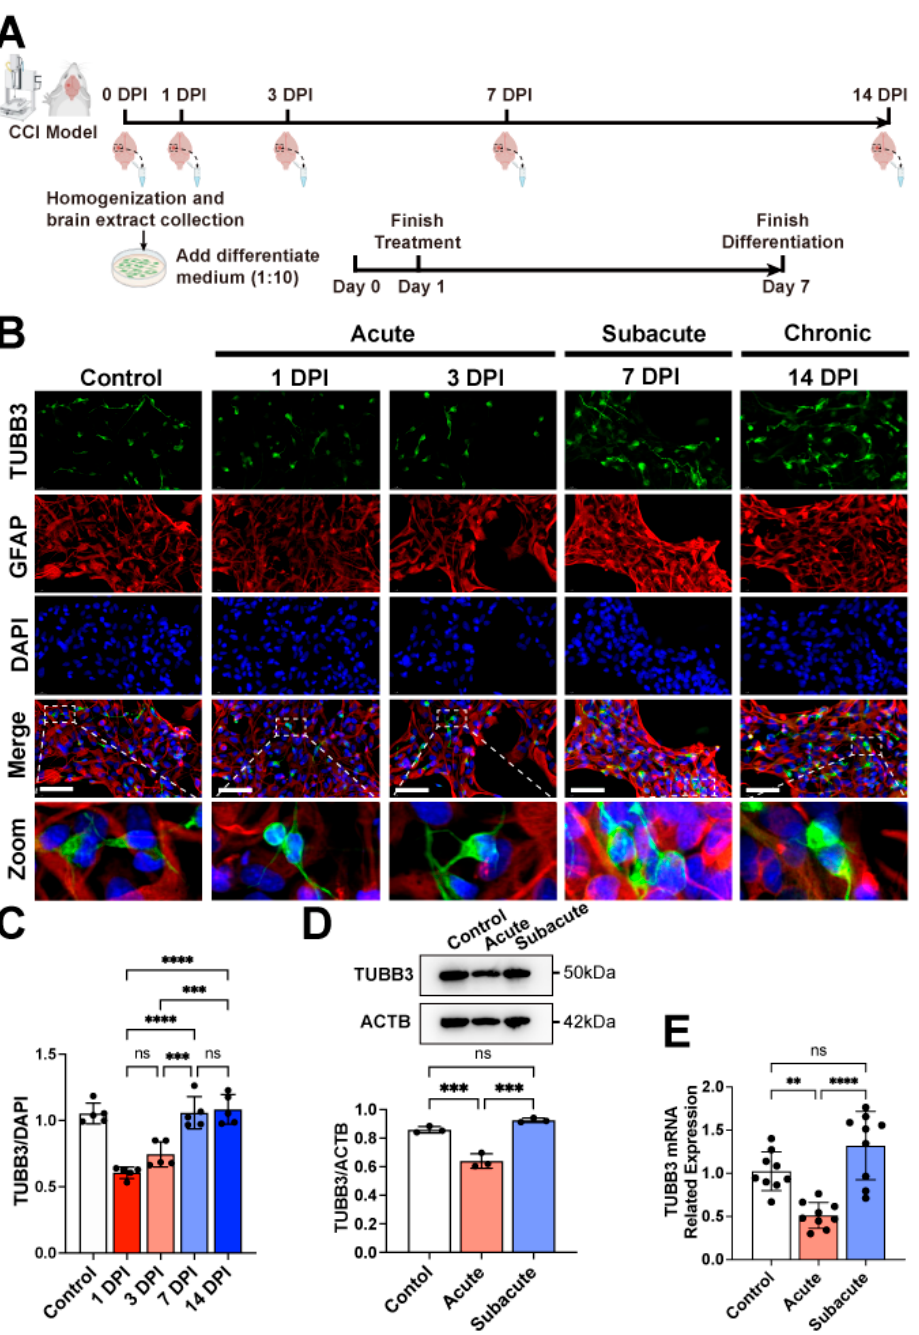
Figure 1. The neuronal differentiation of hNSCs within TBI brain extract at different phases. The brain extracts of CCI mice with different injury times were collected and added to a hNSC differentiate medium with a ratio of 1:10 to simulate the TBI microenvironment in vitro ( A ). Immunofluorescence revealed that hNSCs could differentiate into TUBB3 + neurons and GFAP + astrocytes ( B ). The statistical analysis of mean fluorescence intensity (MFI) of TUBB3/DAPI showed an increasing ratio of TUBB3 + cells with the progression of days post-injury ( C ). Related protein and mRNA expression of TUBB3 also confirmed differences between the acute and subacute phases ( D , E ). The black circle in ( C – E ) represented the individual value of each sample. Bar scale: 50 μ m; **: p < 0.01; ***: p < 0.001; ****: p < 0.0001; ns: p ≥ 0.05. CCI: Controlled Cortical Impact; DPI: Day